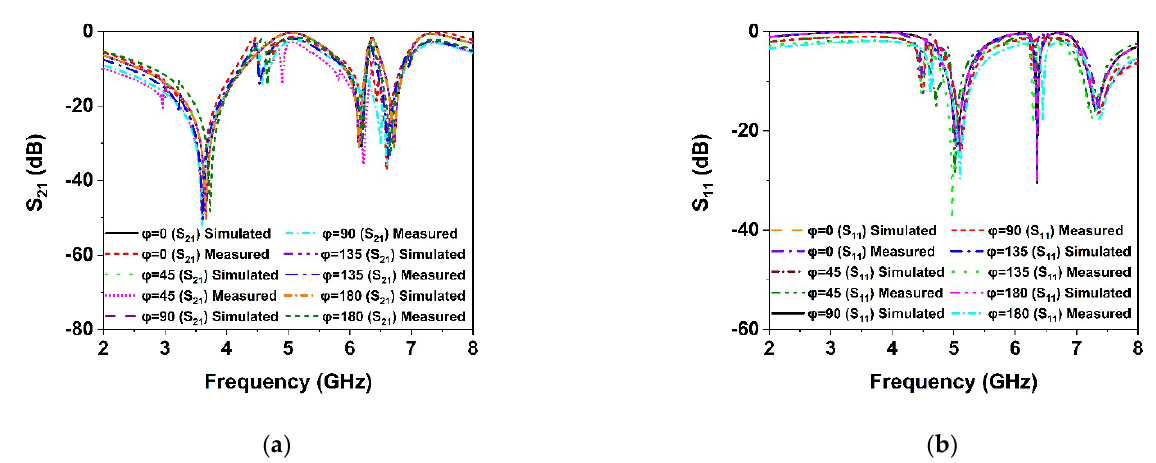
Figure 14. Polarization angle insensitivity experimental results ( a ) S 21 and ( b ) S 11.